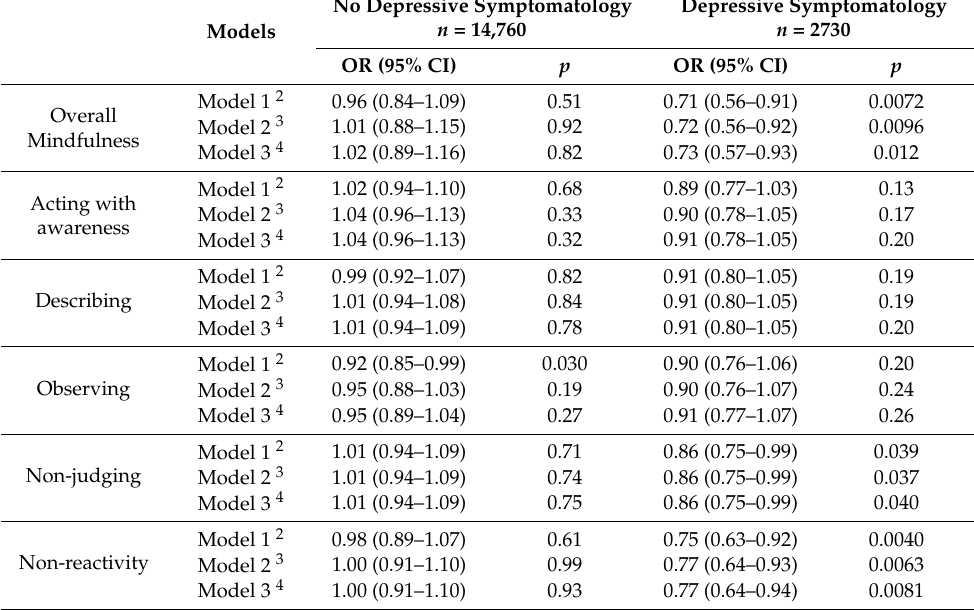
Table 2. Multivariable logistic regression models between mindfulness 1 and its subscales 1 and the Metabolic Syndrome according to depressive symptomatology in 17,490 individuals (NutriNet-Sant é study, France, 2011–2014). No Depressive Symptomatology Depressive Symptomatology n = 14,760 n = 2730 Models OR (95% CI) p OR (95% CI)